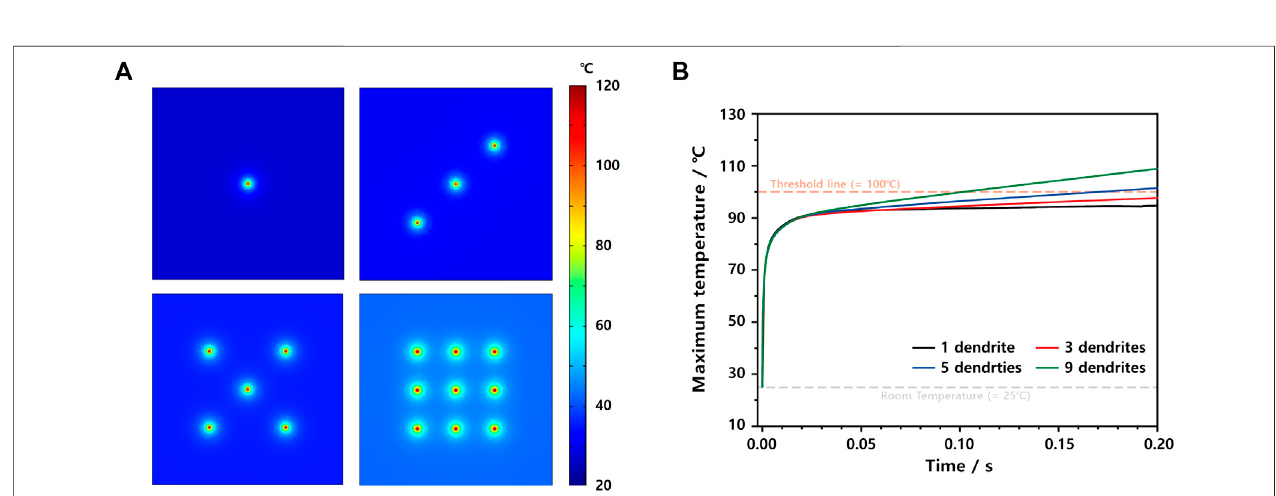
FIGURE 5 | Thermal 2D color maps at 0.2 s of ISC models having (A) one large Li dendrite of 3 μ m radius and (B) nine small Li dendrites of 1 μ m radius. (C) Maximum temperature pro fi les and (D) average temperature pro fi les of the aforementioned two ISC models, with the control case having one small Li dendrite of 1 μ m.